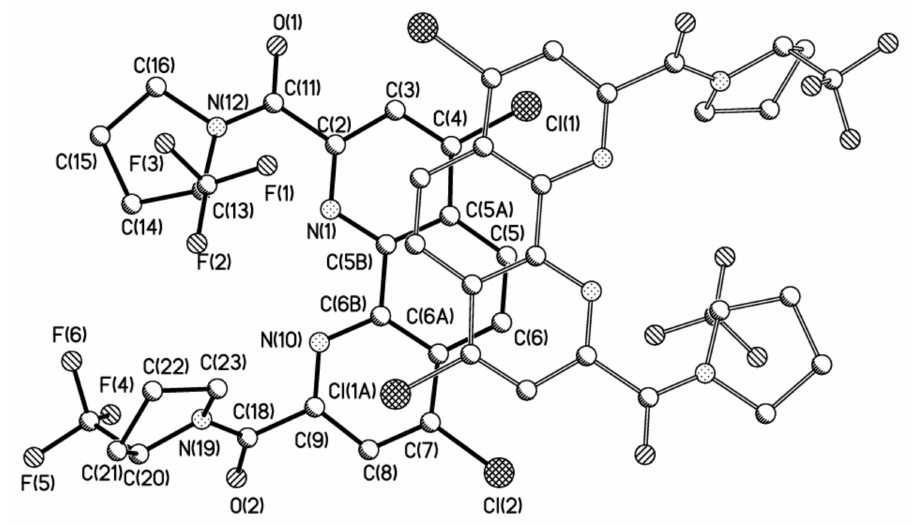
Figure 8. The molecular packing of 2B .